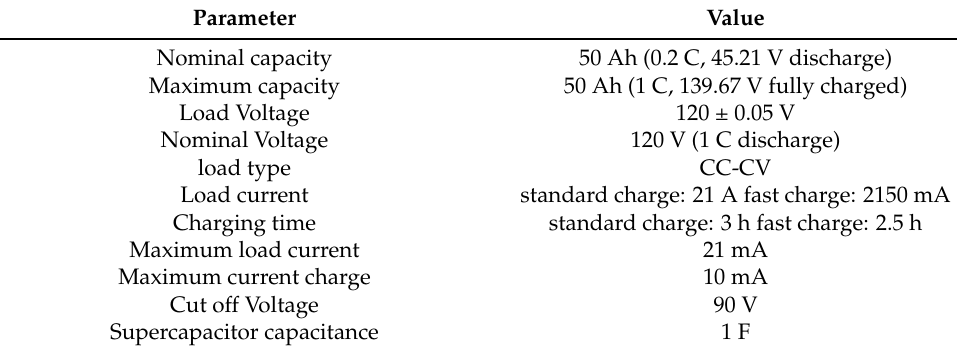
Table 2. Battery and supercapacitor